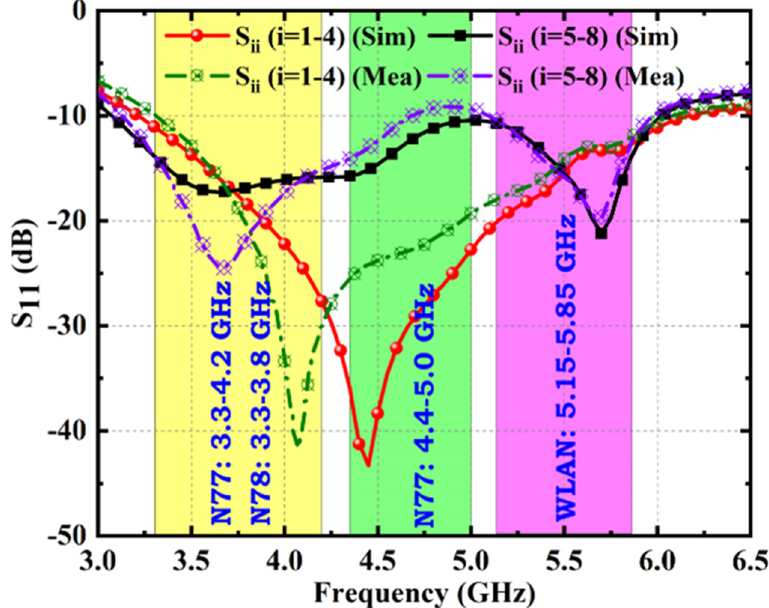
Figure 10. S11 response (simulated and measured).